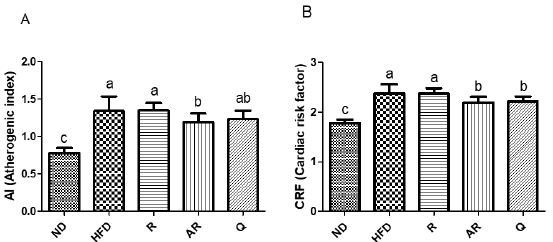
Figure 3. Effect of experimental diets on atherogenic index ( A ) and cardiac risk factor (CRF) ( B ) in mice fed with experimental diets for 7 weeks. Atherogenic index (AI) = (total cholesterol - high density lipoprotein cholesterol)/ high density lipoprotein cholesterol; CRF = total cholesterol/high density lipoprotein cholesterol. The results are expressed as means ± standard deviation. a-c Different letters above bars represent significant differences ( p < 0.05). ND, normal diet; HFD, high-fat diet; R, high-fat diet with 100 mg/kg rutin/day; AR, high-fat diet with 100 mg/kg acid-treated rutin/day; Q, high-fat diet with 100 mg/kg quercetin/day.